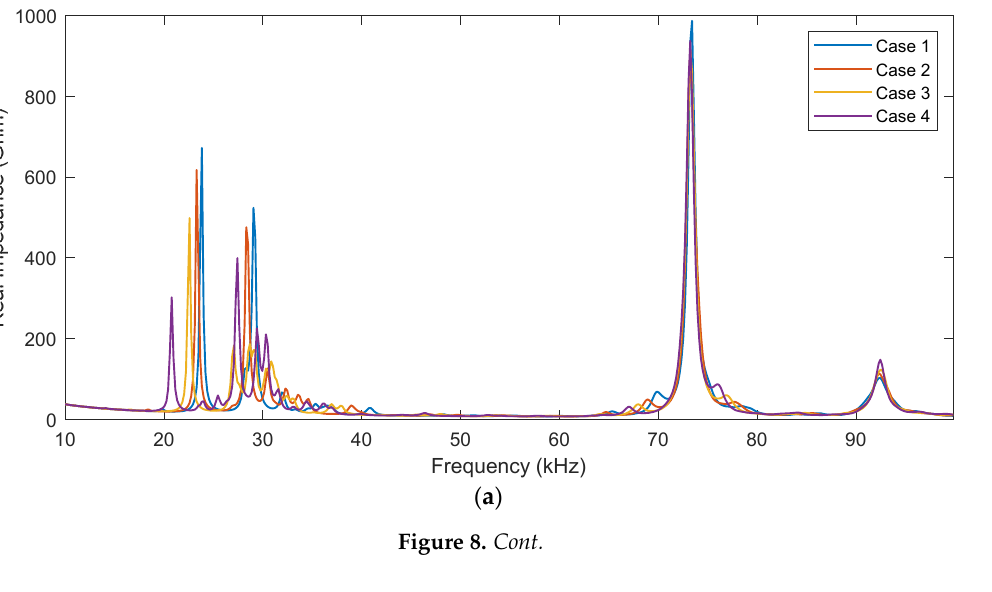
Table 4. The peak frequency vs damage case.